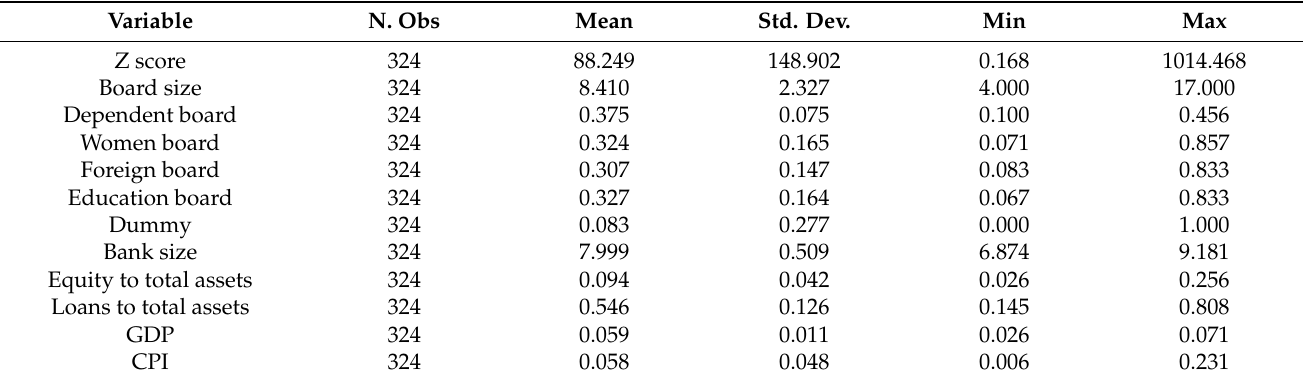
Table 2. Summary